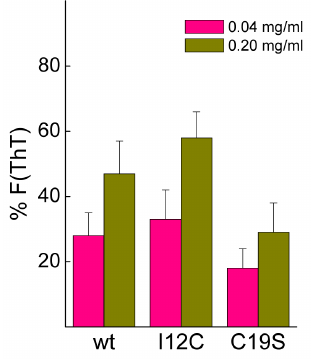
Figure 5. Stability of amyloid aggregates under calcium carbonate crystallization conditions. Amyloid dissociation was determined as the percentage of thioflavin T (ThT) fluorescence remaining after 20 h incubation in 0.1 M CaCl 2 .